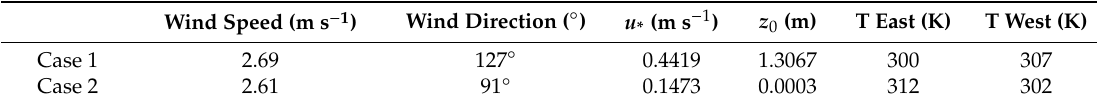
Table 4. Wind and temperature data used to set the boundary conditions in the idealized street canyon in the two cases